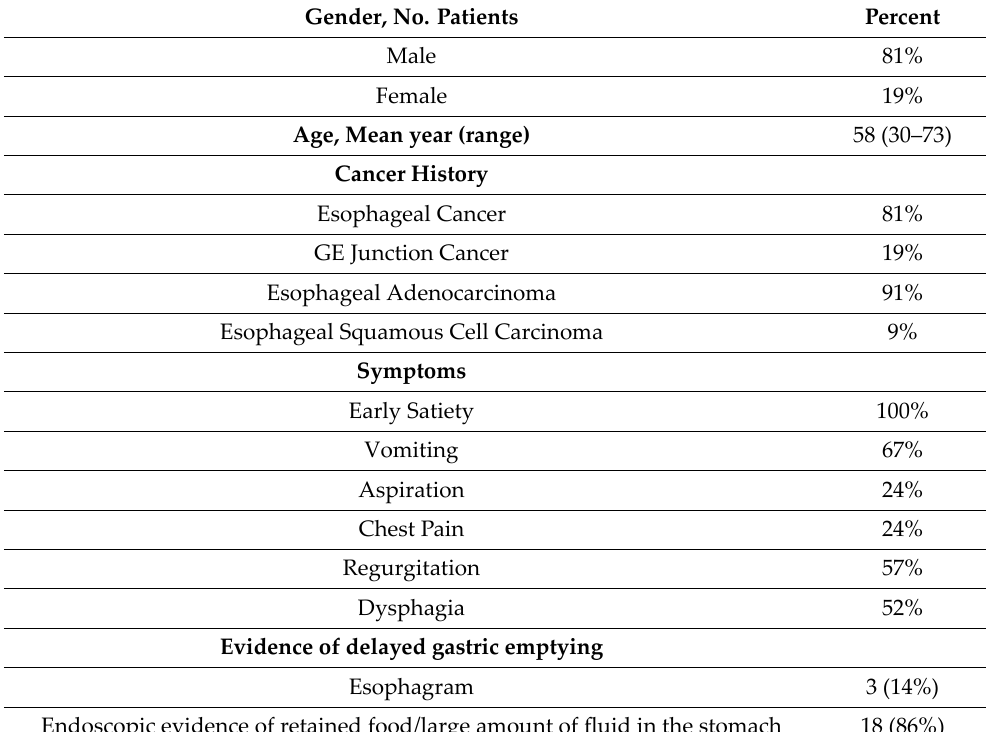
Table 1. Baseline Characteristics of Study Population.